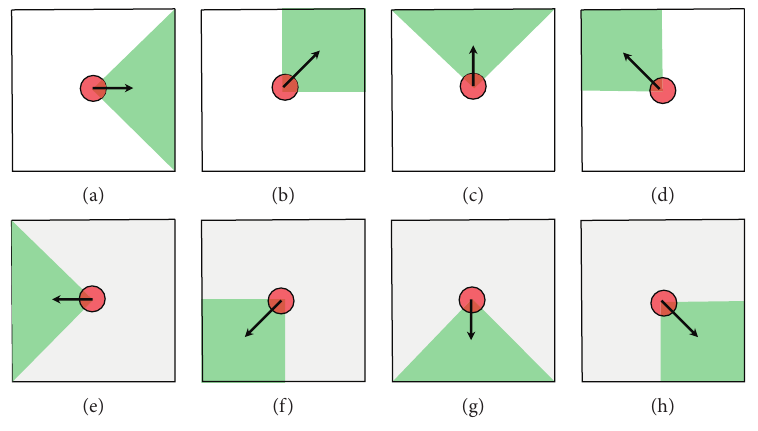
Figure 6: Possible emotion perception domain of evacuation individual j at time t .